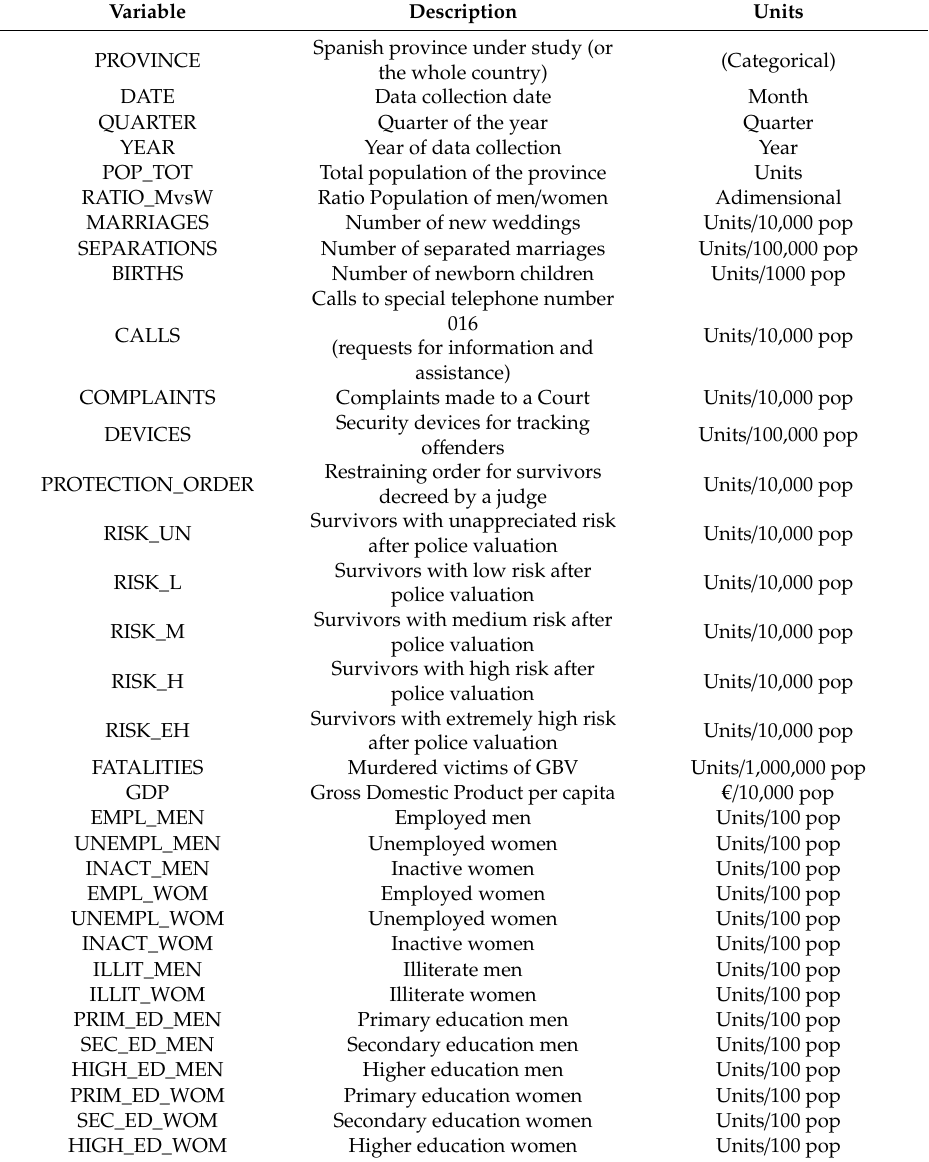
Table 1. Description of the